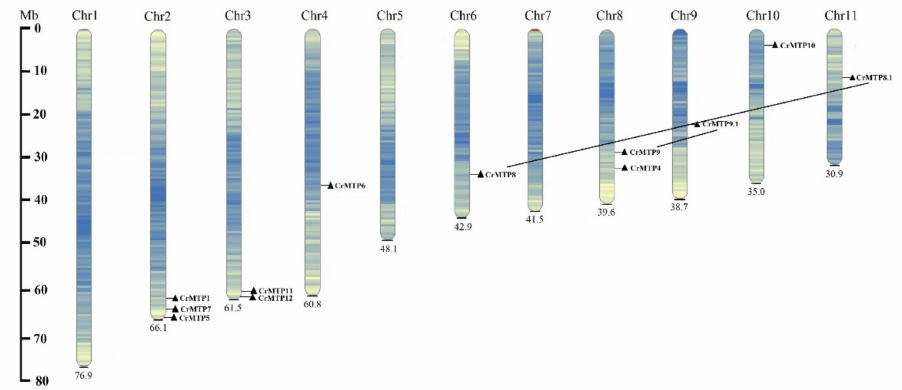
Figure 2. Chromosomal location and gene duplication of 12 CrMTP genes in the C. rosea